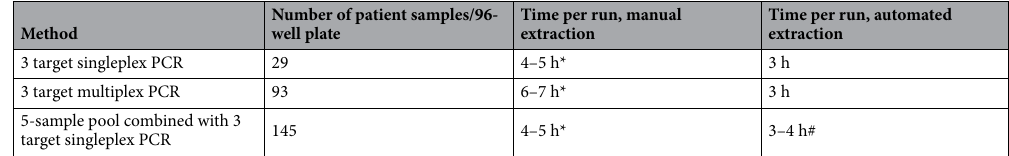
Table 2. Overview of analysis methods. *Manual extraction allows extraction of 23 samples at a time at ~ 1 h per round. # Automated extraction for samples combined prior to RNA extraction which allows for extraction of 96 samples at a